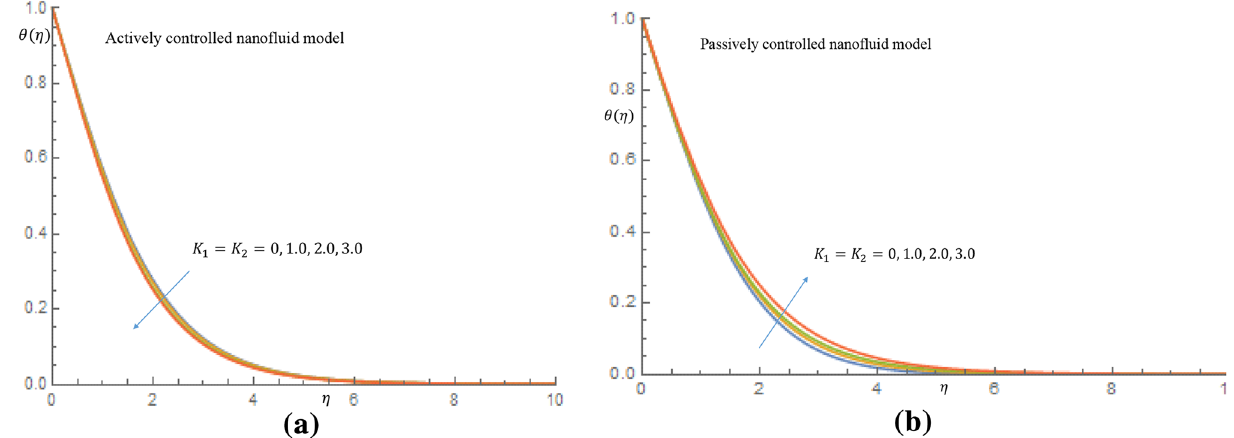
Figure 2. ( a ) Effect of K 1 = K 2 on temperature profile when δ t = δ n = 0.1 . ( b ) Effect of K 1 = K 2 on temperature profile when δ t = δ n = 0.1 .